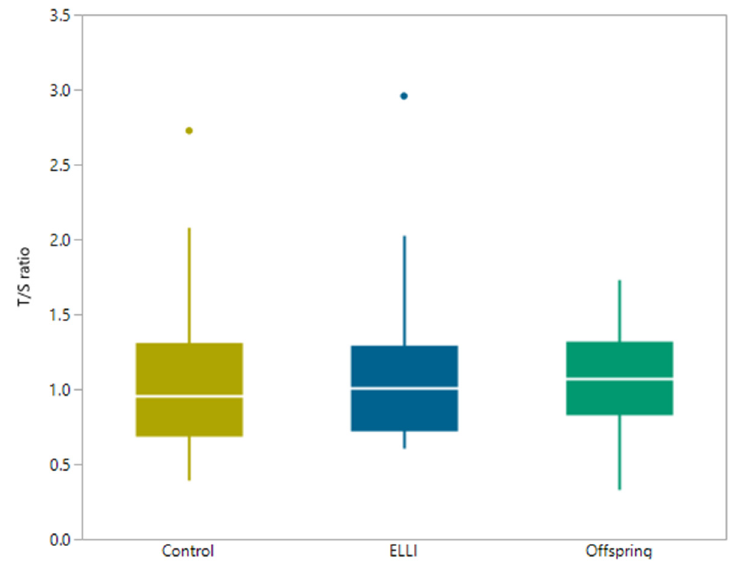
Figure 5. Average T/S ratio as measured by qPCR. T/S ratio obtained by dividing concentration of telomeric reaction by concentration of SCG (Single Copy Gene) reaction, as calculated using standard curve reactions. N ELLI = 12, N control = 17, and N offspring = 12. All pair comparison (Dunn Joint Ranking) non-significant.